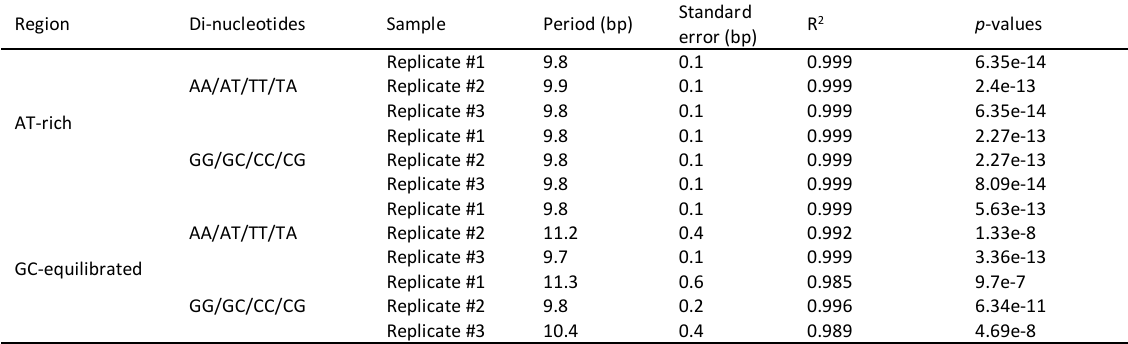
Supplementary Table 5. Summary of periods, standard errors, coefficient of determination R 2 , and p -values ( F -test) determined after linear regression fitting on autocorrelation plots for AA/AT/TT/TA and GG/GC/CC/CG frequencies in AT-